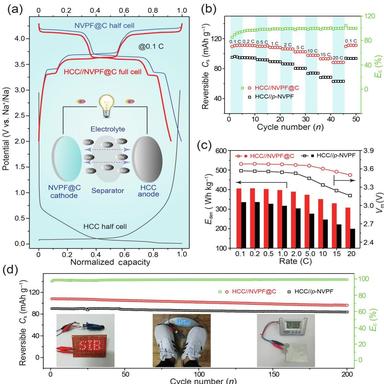
(Color online) The full-cell performance of NVPF@C and p-NVPF cathodes. (a) GCD curves of HCC//NVPF@C SIFBs, and the contrastive NVPF@C and HCC electrodes in half cells; inset is the schematic illustration of HCC//NVPF@C; comparisons of (b) rate performance, and (c) Eden and Vm values of NVPF@C and p-NVPF cathodes in SIFBs tested at varied rates from 0.1 to 20 C; (e) cycling performance of SIFBs at 0.5C, and the insets show the practical application of HCC//NVPF@C SIFBs.